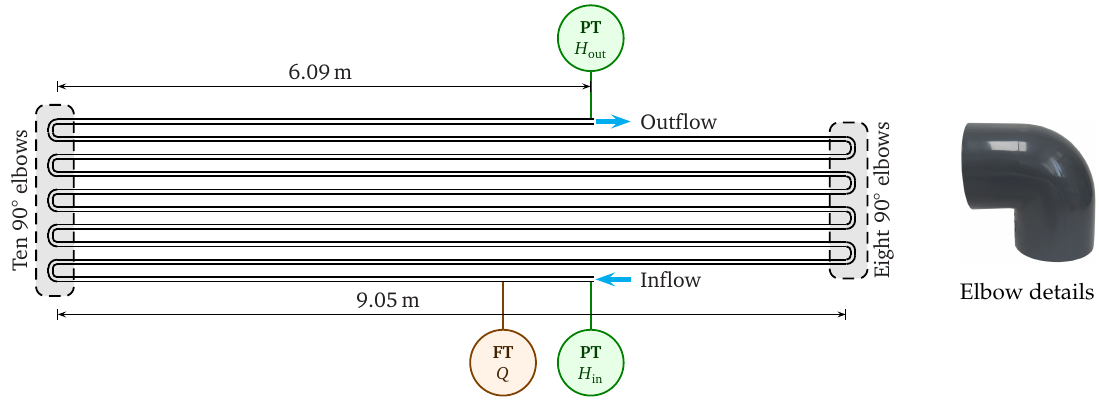
Figure 3. Prototype pipeline in the National Institute of Technology of Mexico, at Tuxtla Gutiérrez.